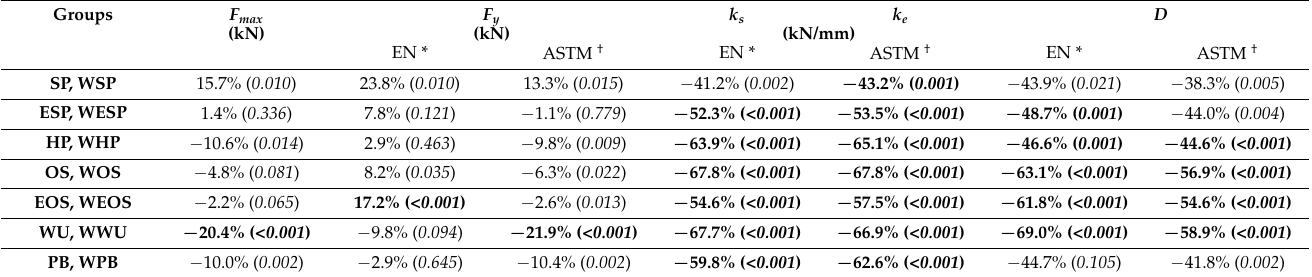
Table 4. Mean difference, as a percentage, between unweathered and weathered STCs by